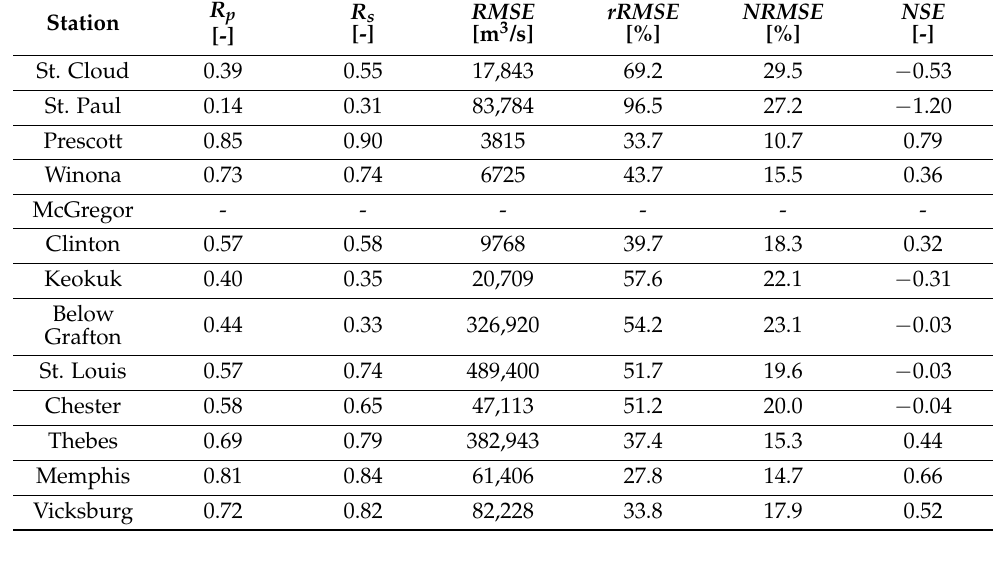
Table 3. Validation phase: Performance indices of the comparison between the observed and simulated discharges: Pearson correlation coefficient, R p , Spearman correlation coefficient, R s , Root